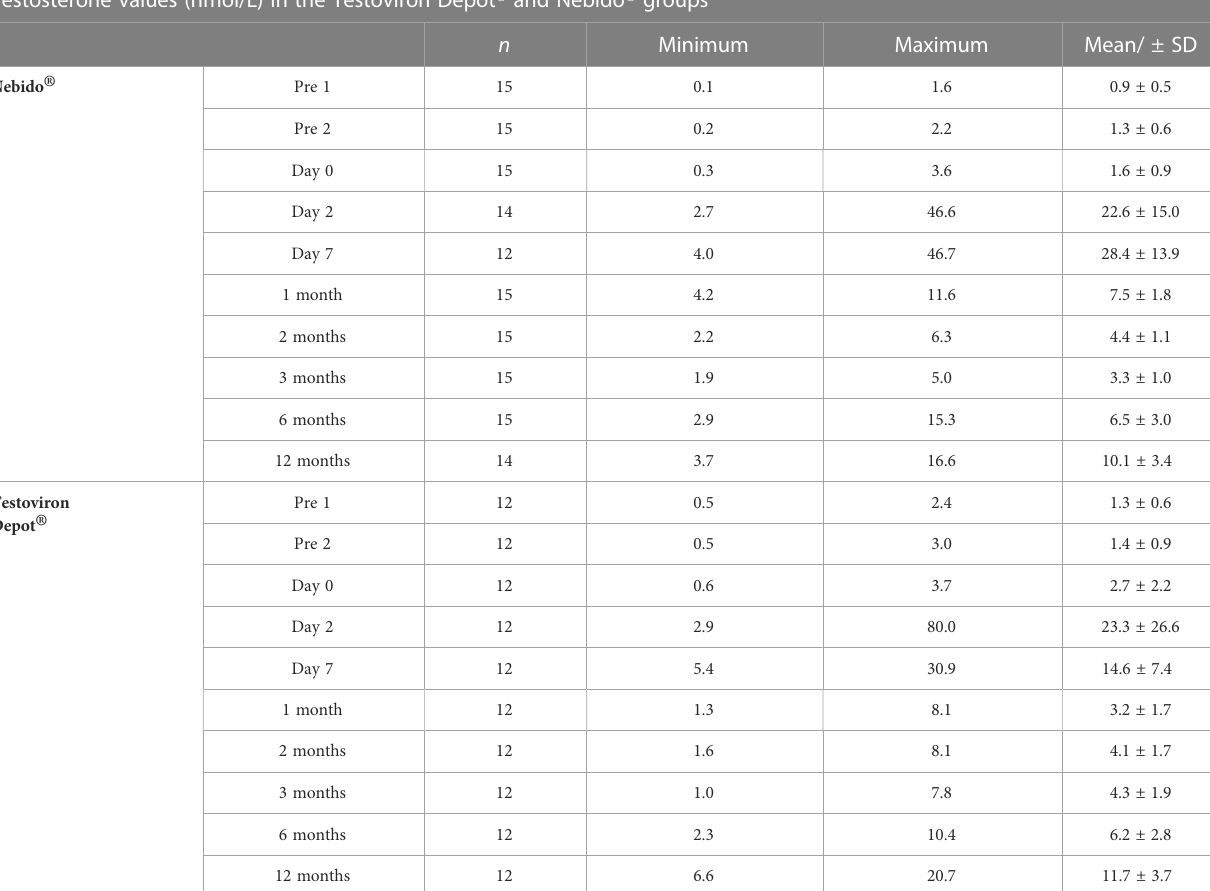
TABLE 3 Testosterone values in the patients in the Pubertal Replacement in Boys Study. Testosterone values (nmol/L) in the Testoviron Depot ® and Nebido ® groups